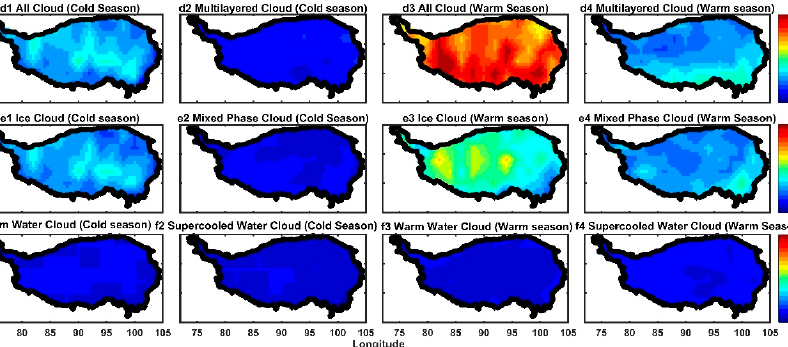
Figure 3. Four-year short-wave cloud optical depth of four different cloud phases over the TP. ( a1 – a3 ) represent the cold season; ( b1 – b3 ) represent the warm season. The spatial resolution is a 0.5° × 0.5° grid (Here, ice clouds, liquid clouds refer to the case of the single-layer clouds. Part of the data for water clouds during the cold season is missing).